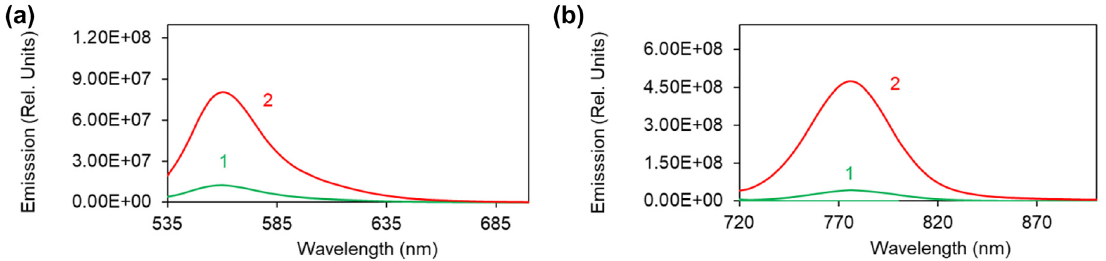
Figure 2: Emission spectra on top of glass, Ag, and Au. (a) Emission spectra of Rh590:PMMA ( n = 8 g/L) deposited on glass (trace 1) and on Ag (trace 2). The emission spectra are normalized by the absorbed pumping intensity. (b) Same for HITC:PMMA ( n = 10 g/L) deposited on glass (trace 1) and on Au (trace 2).